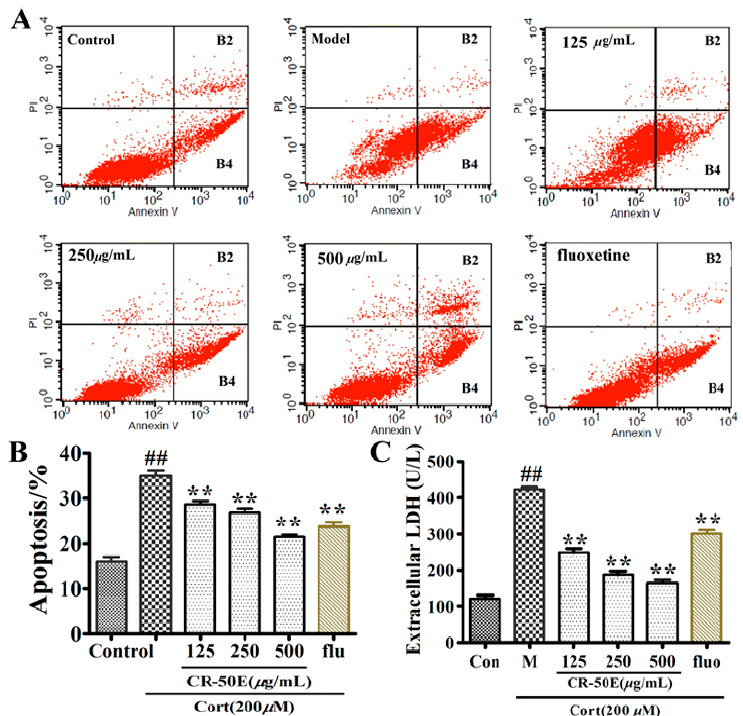
Figure 2. Effect of CR-50E on corticosterone-induced cell apoptosis and LDH released. ( A ) : The stained cells with Annexin V-FITC and PI labeling were analyzed by flow cytometry; ( B ): effect of CR-50E on corticosterone-induced distributive change of early and late apoptotic cells. ( C ): level of LDH. Results are presented as means ± SD ( n = 6). ** p < 0.01, compared with control group, ## p < 0.01, compared with corticosterone (Cort).